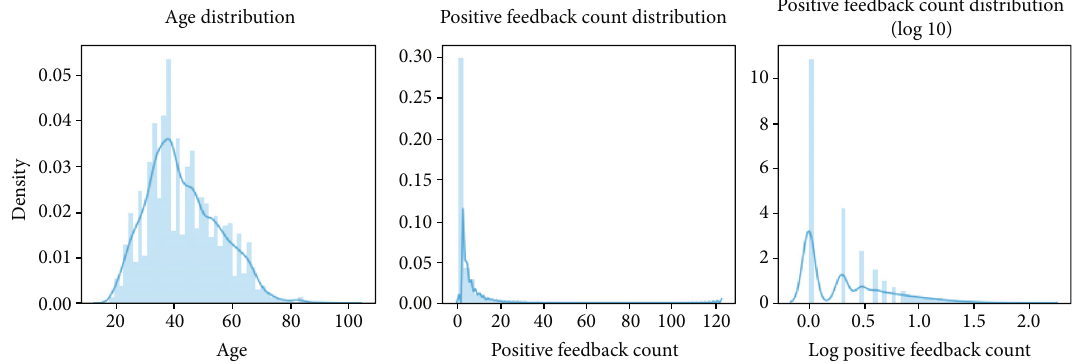
Figure 1: Customer age frequency distributions and positive